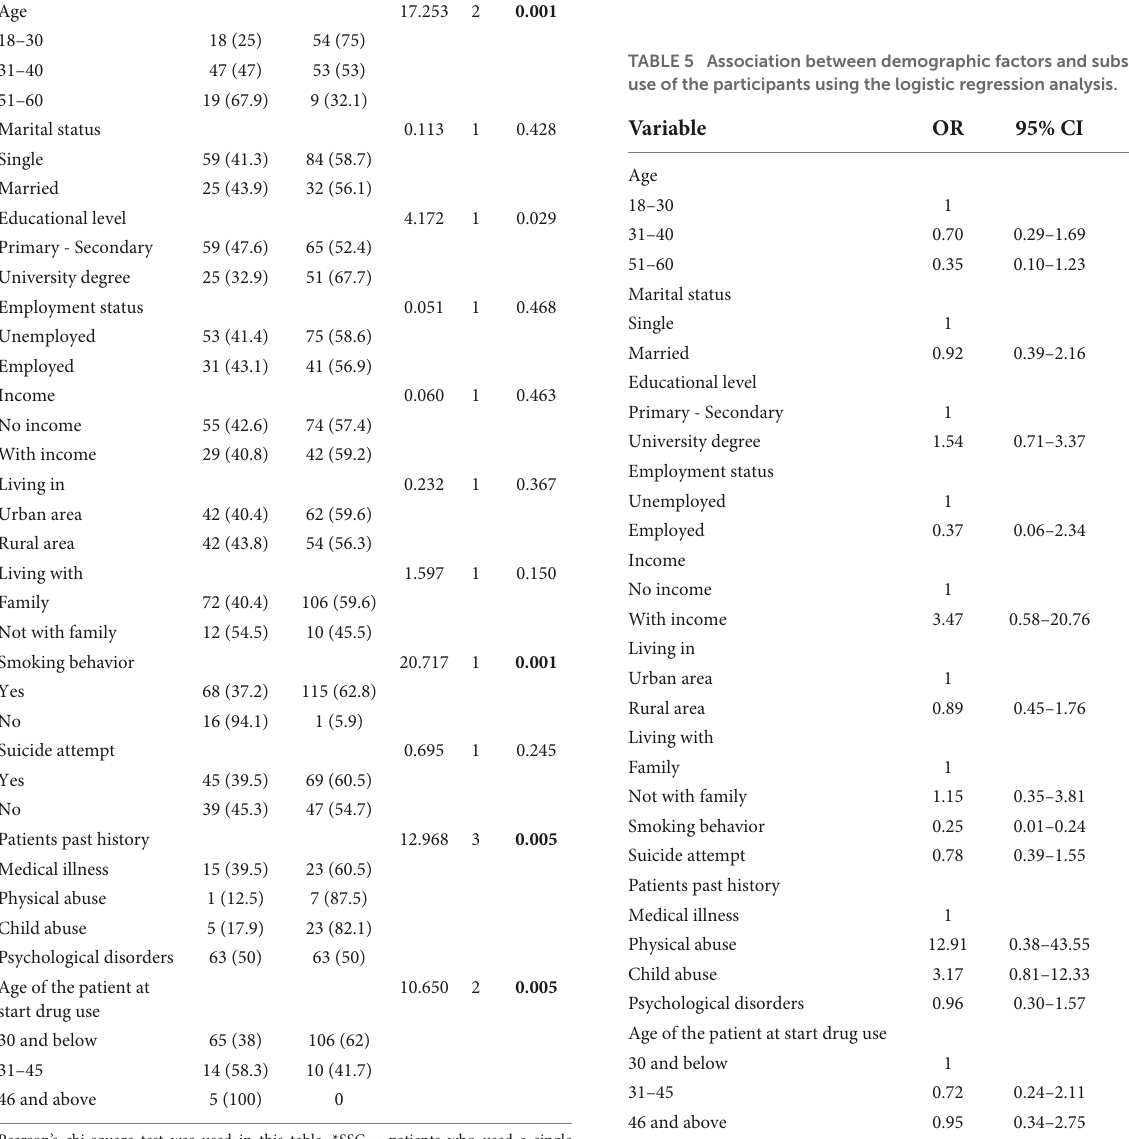
Pearson’s chi-square test was used in this table, *SSC = patients who used a single substance; † MSC = patients who used multiple substances. ‡ p < 0.05. Bold values indicatestatisticalsignificance( p -value < 0.05).